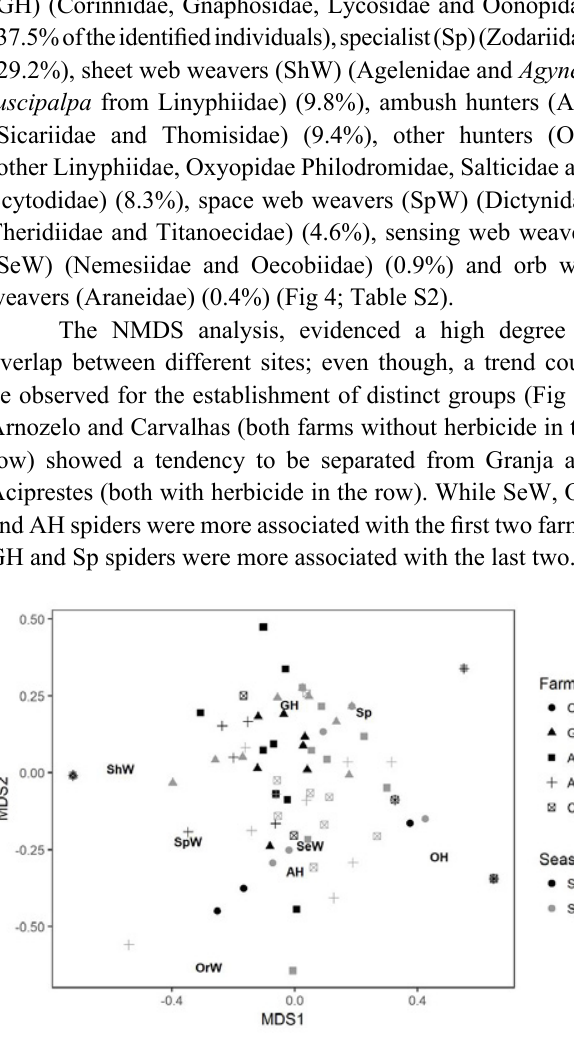
Fig 5. NMDS ordination plots of functional groups of spiders associated with the study vineyards. The ultimate 2-dimensional NMDS solution was found with Euclidean dissimilarity and had an associated stress of 0.194. Ac – Aciprestes; Ar – Arnozelo; Ca – Carvalhas; C – Cidrô; G – Granja; Sp – spring; Su – summer; GH – ground hunters; Sp – specialists; ShW – sheet web weavers; AH – ambush hunters; OH – other hunters; SpW – space web weavers; SeW – sensing web weavers; OrW – orb web weavers. Ac, C and G were treated with herbicide in the inter-row while Ar and Ca were not treated with